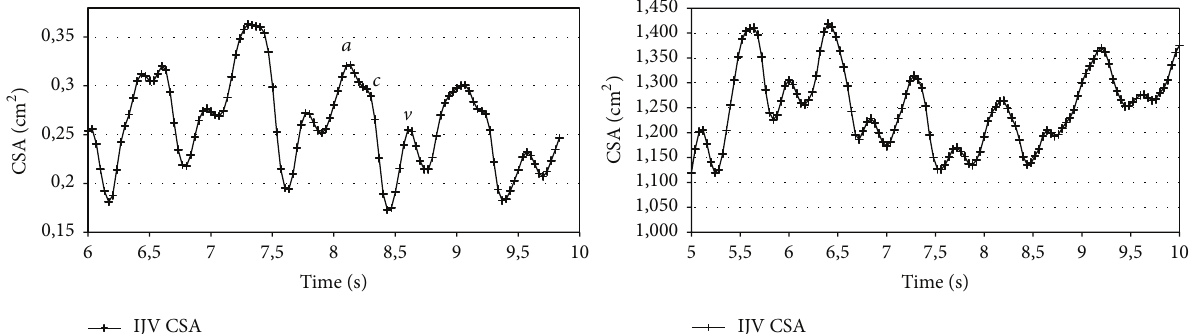
Figure 2: Instantaneous cross-sectional area (CSA) of the internal jugular vein measured using ultrasound B-mode for about 5 seconds.